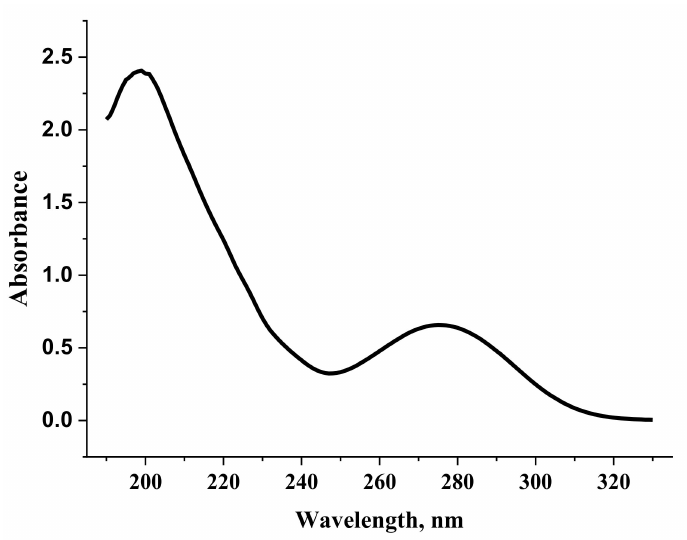
Figure 10. Electronic absorption spectrum of a diclofenac sodium solution